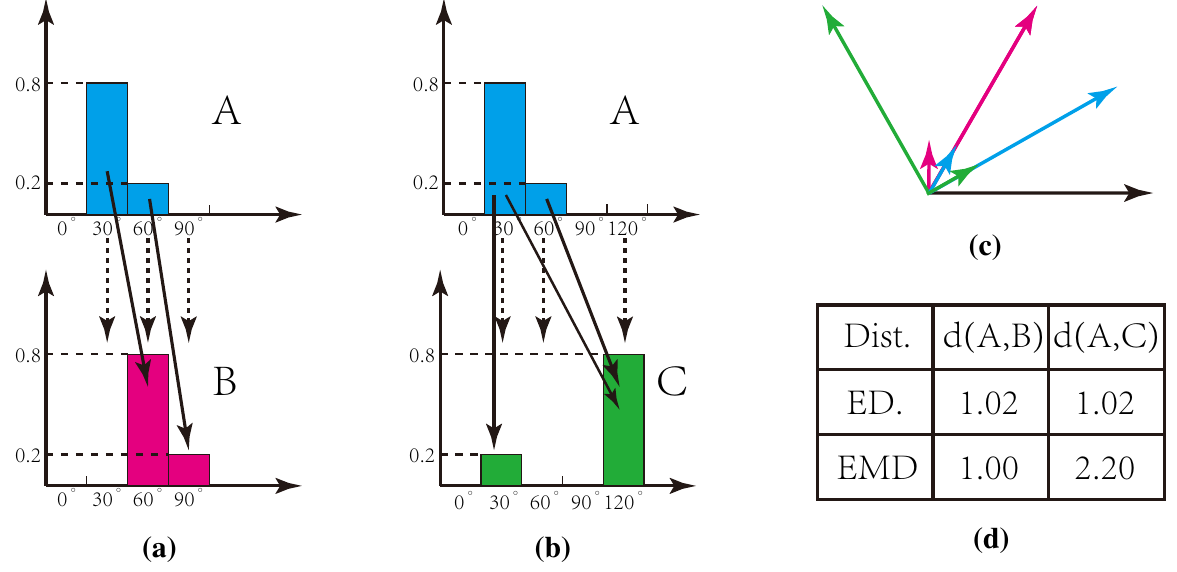
Figure 9. Measurement of the histogram distance by Euclidean and Earth mover distance